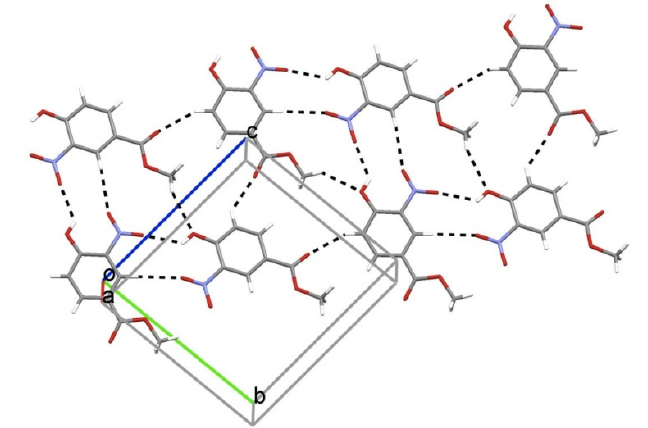
Figure 2. Centrosymmetric dimers forming sheets in the bc plane with hydrogen bonds drawn as dashed